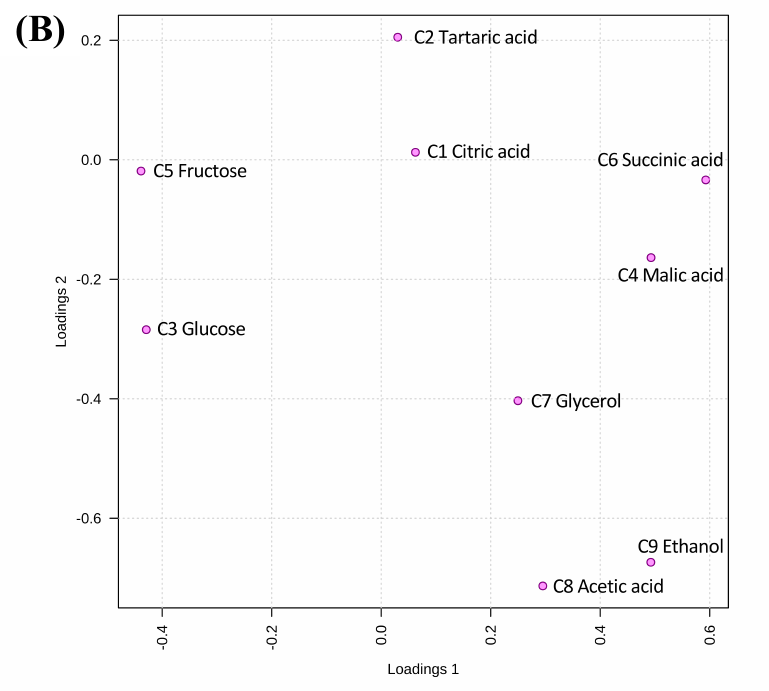
Figure 6. Nonvolatile compounds from inoculated fermentations differentiates from sterile juice. ( A ) PLS-DA scores plot and ( B ) loading plot of the variables with components 1 and 2 based on the nonvolatile composition of sterile juice (eight spoked asterisk) and inoculated fermentations with candidate yeast strains and S. cerevisiae BY4742. Each symbol in panel A represents a yeast strain and the ellipse around symbols represents a 95% confidence region of biological and technical